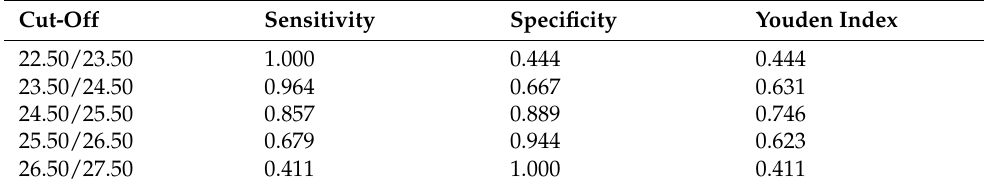
Table 6. Sensitivity and specificity of the MoCA-K scores for the detection of MCI ( n = 92). Cut-Off Sensitivity Specificity Youden